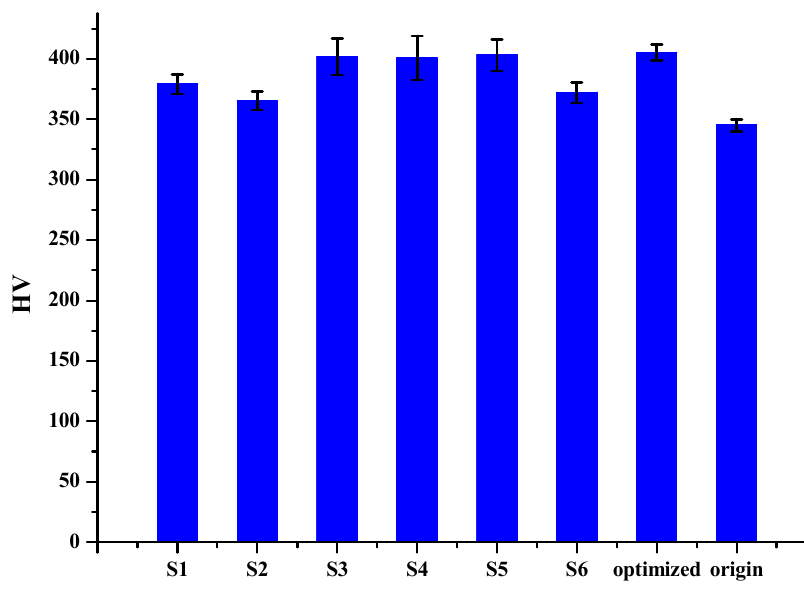
Figure 13. Overall hardness for each